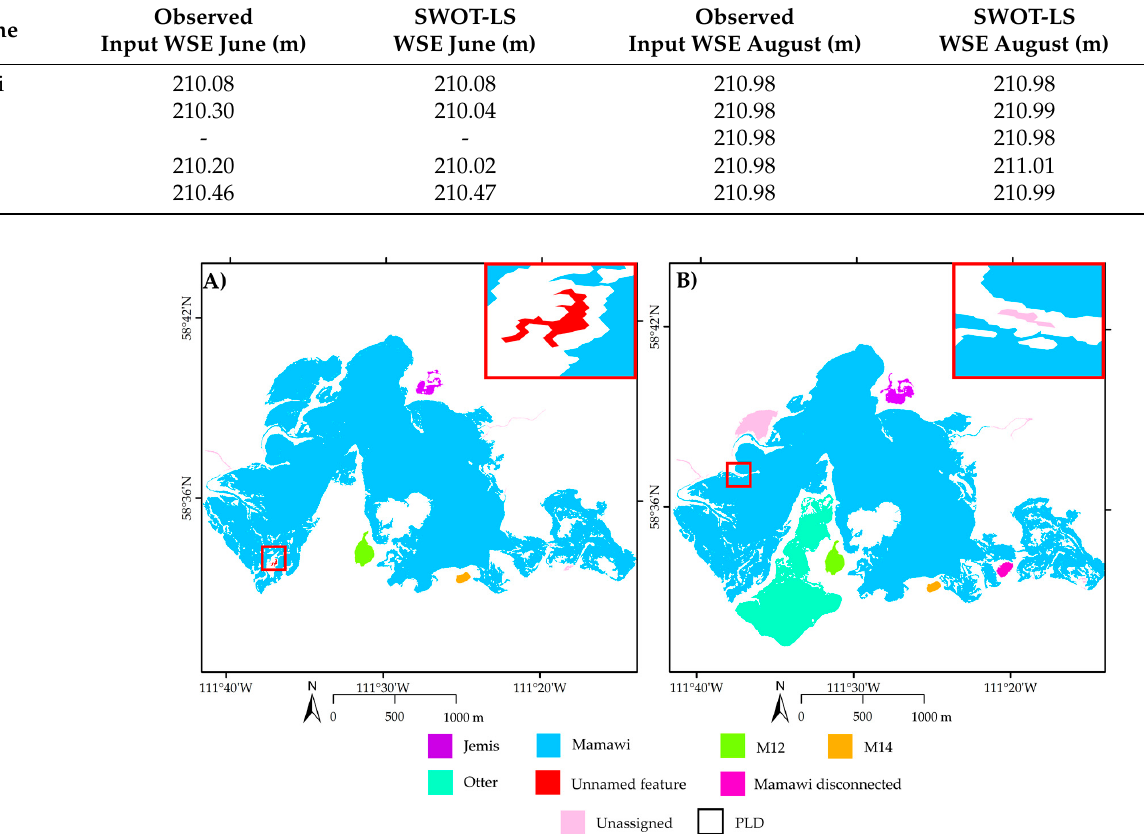
Figure 11. Results of SWOT-LS Lake_SP Prior product simulation on Mamawi Lake. Coloured lakes represent the separated lake forms observed in the SWOT-LS lake product. SWOT-LS simulation from ( A ) 1 June and ( B ) 3 August.